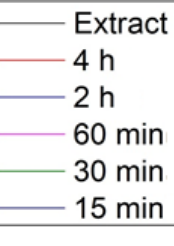
Figure 4. ( A ) Representation of transmission electron microscopy (TEM) of CS-AgNPs. ( B ) Particle size distribution of nanoparticles.